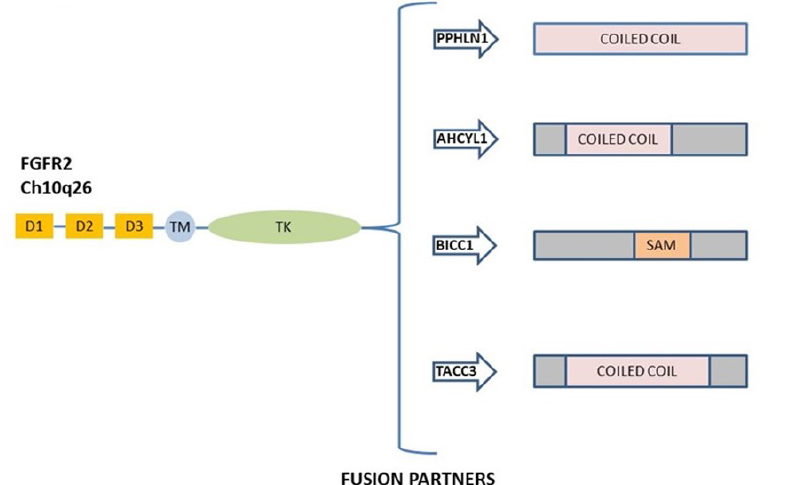
Figure 2. Schematic representation of commonly FGFR2 gene fusion in ICC. The most frequent rearrangement partners FGFR2–PPHLN1, FGFR2–AHCYL1, FGFR2–BICC1, and FGFR2–TACC3 are all shown. D: domain; TM: transmembrane